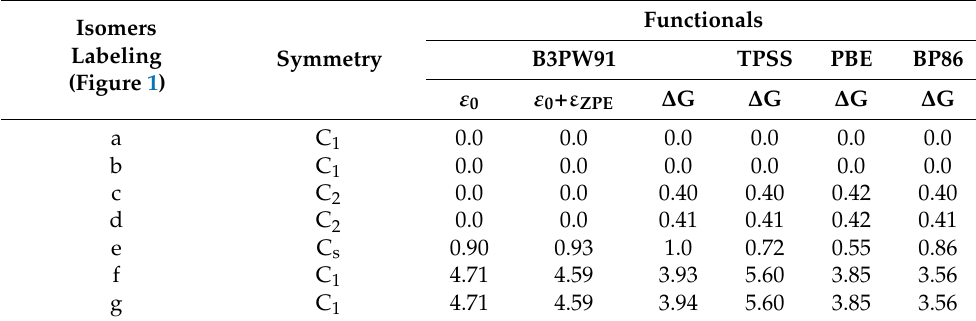
Table 1. Relative energy in kcal/mol of the low-lying isomers depicted in Figure 1 labeled from a to g, employing various density functionals: B3PW91, TPSS, PBE, and BP86, with the def2TZVP basis set. Point group symmetry (Symmetry), electronic energy ( ε 0 ), electronic energy plus zero-point energy ( ε 0 + ε ZPE ), and Gibbs free energy ( ∆ G) computed at room temperature. The tiny values of relative Gibbs free energy (0.41 kcal/mol) differences among isomers labeled a, b, c, and d and computed at 298.15 K are due to the rotational entropy, which depends on the point group